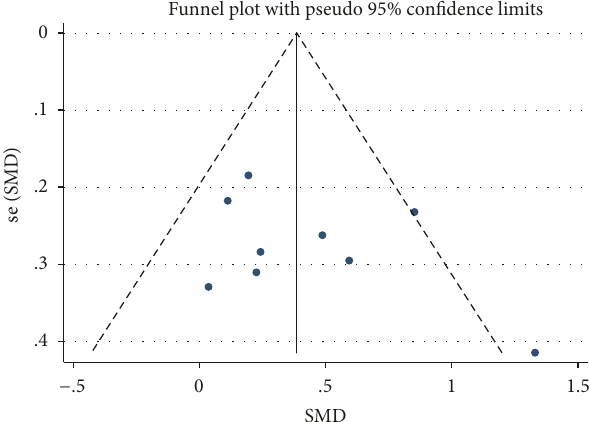
Figure 3: Funnel plot of studies included in Figure 2. Dots represent the results of each study. Funnel plots showing some asymmetry of nine trials reporting the efficacy of the bisphosphonates versus control groups in change of BMD in the lumbar spine in IBD patients.